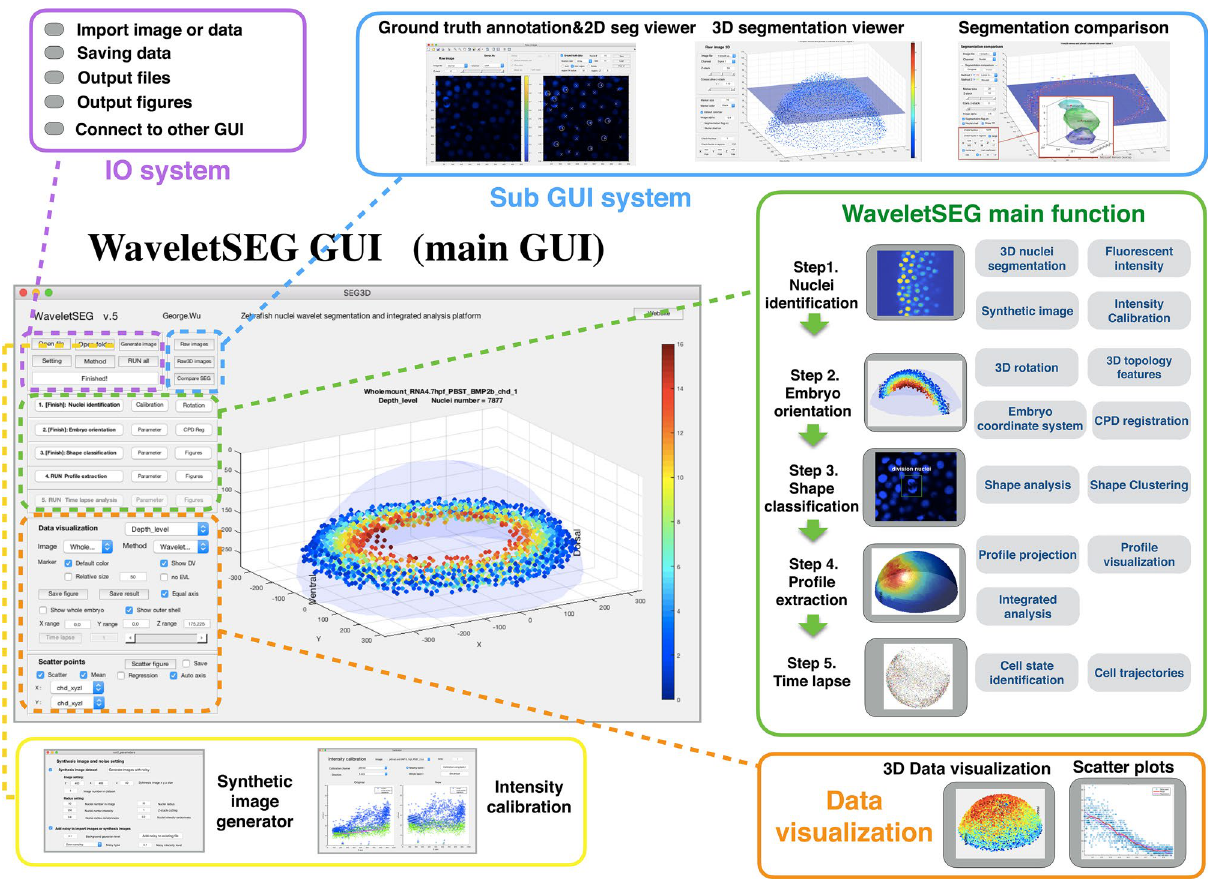
Figure 4. WaveletSEG software main function structure and GUI. WaveletSEG is the image processing analysis platform which integrates all main and extension functions including IO system, extension GUI and data visualization system in one GUI. The WaveletSEG main function block consists of five main steps that can run independently including 1. Nuclei identification, 2. Embryo orientation, 3. Shape classification, 4. Profile extraction, and 5. Time lapse steps. In the nuclei identification step, users can do intensity calibration by using nuclei intensity or after wavelet-based segmentation. In IO system block, users can directly import microscope image files or intermediate data files into WaveletSEG, and save or output data results or figures directly from the GUI. We also developed a set of segmentation validation tools in WaveletSEG including synthetic data generator, 3D ground truth labeling system, 2D and 3D segmentation viewer sub-GUI, and segmentation method comparison extension GUI. In WaveletSEG data visualization block, 3D segmentation and quantification or other results such as embryo topology features can be easily displayed or saved in the WaveletSEG data visualization system. User can also create scatter plots by selecting menu options to explore the relationship between